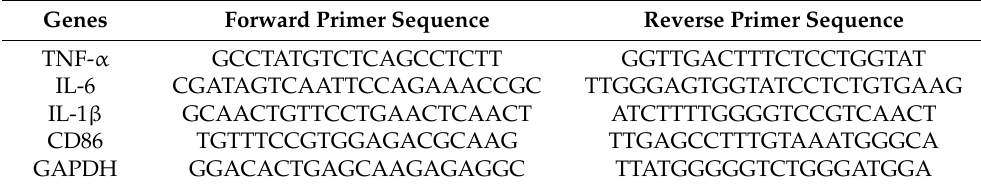
Table 2. The primers used for the evaluation of pro-inflammatory-related gene expression in RAW264.7